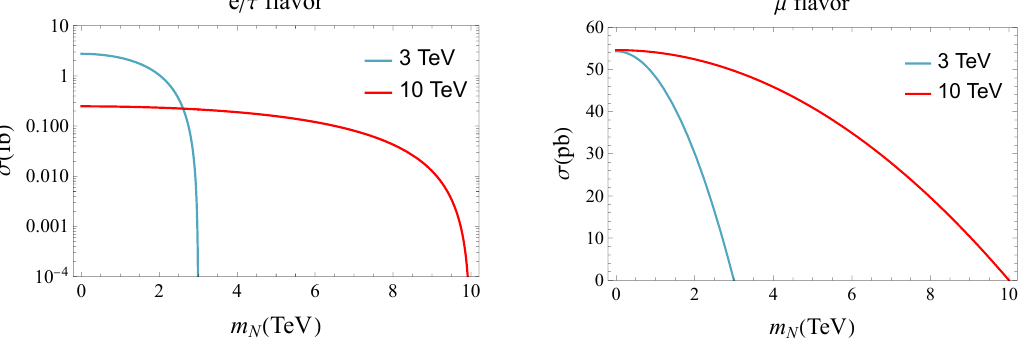
Figure 2 . The cross section of the 2-to-2 process µ + µ − → N ‘ + ¯ ν ‘ as a function of m N for ‘ = µ and e respectively. The blue curve refers to